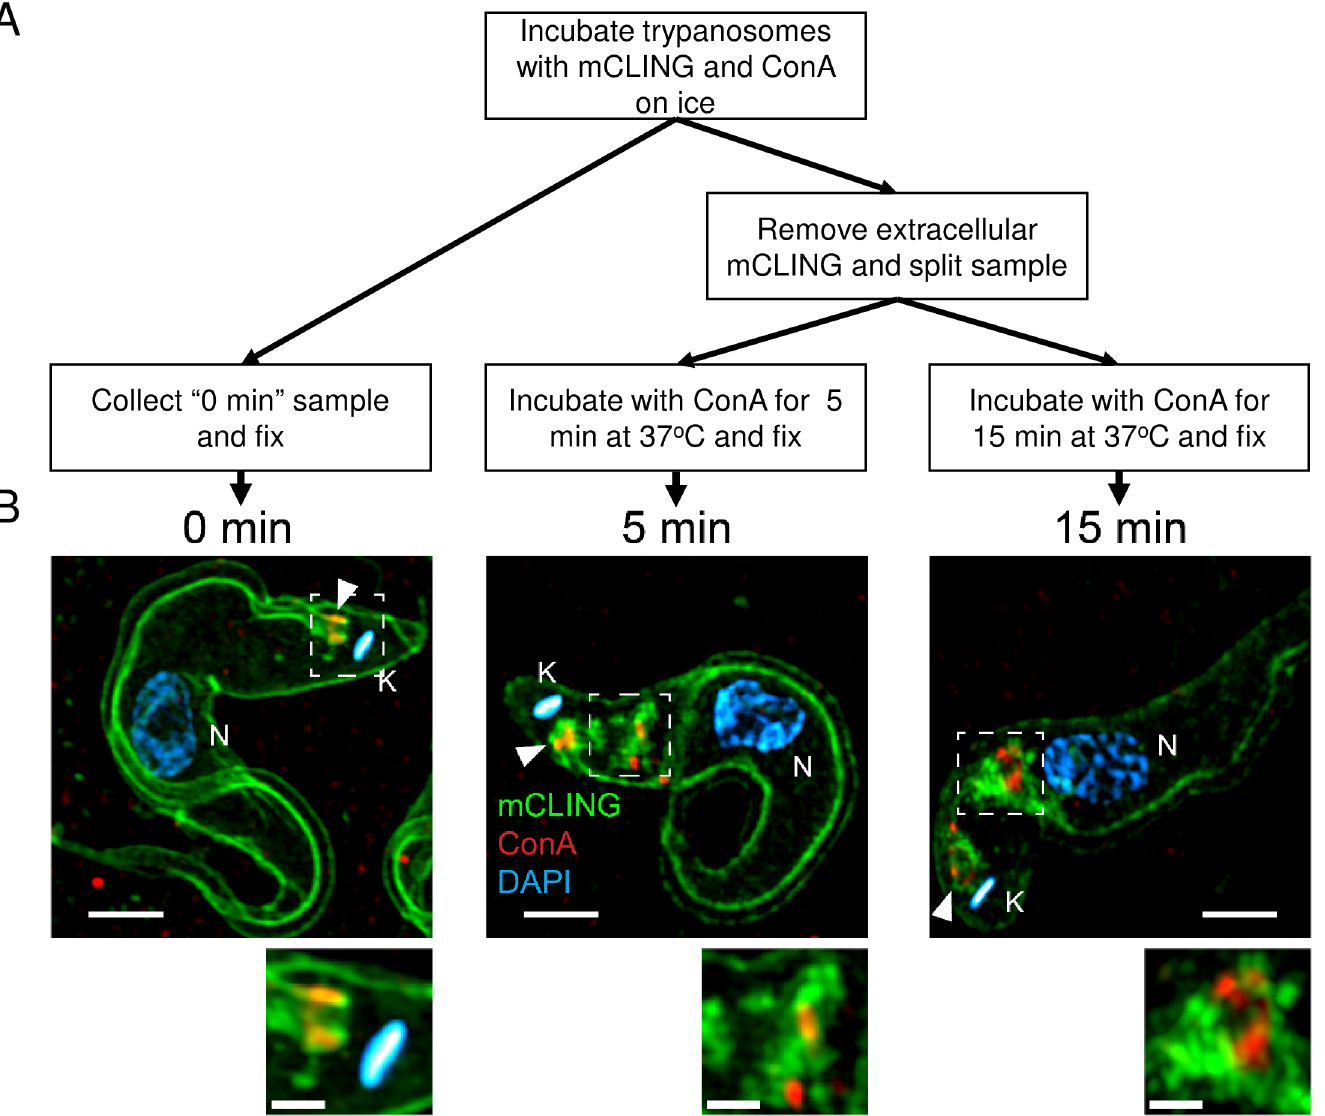
Fig 4. Labeling of endosomes with ConA and mCLING. Trypanosomes were incubated with mCLING-488 and ConA-594 for 15 minutes on ice, then exogenous mCLING was removed. Cells were incubated at 37 ˚ C with ConA-594 for 5 or 15 minutes and fixed. DNA in the kinetoplast and nucleus was stained with DAPI. (A) Simplified flow chart of the experimental procedure. (B) Maximum intensity projections of 3D SR-SIM images. 0 min represents the “No uptake” control (kept on ice); 5 min and15 min images include internalized mCLING-positive endosomes. Boxes (in 5 min and 15 min samples) indicate areas of the trypanosome containing endocytosed mCLING and ConA. ConA is observed at the base of the flagellum in the 0 min and 5 min samples. Small image panels below the larger images show the area enclosed by the box, at a higher magnification. K = kinetoplast. N = nucleus. Arrowheads indicate the posterior bases of flagella. Scale bar in large panels = 2 μm. Scale bare in small panels = 1